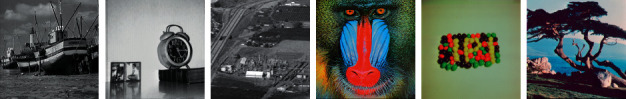
Original images of size 512∗512.